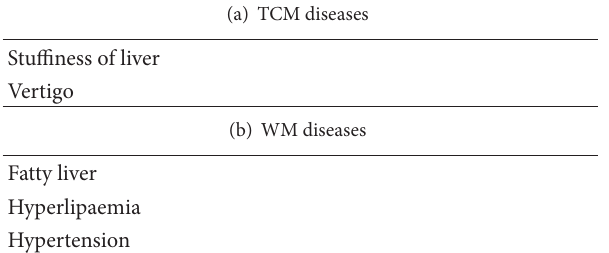
Table 1: Information for template design ( 2